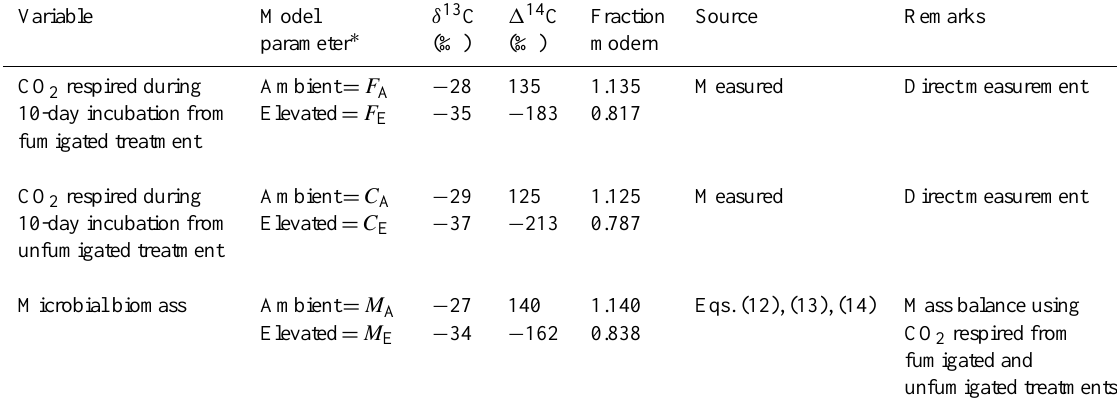
Table 5. Isotopic signatures of microbial biomass and biomass respiration measured for the sandstone topsoil (0–5cm) in April 1996. Variable Model δ 13 C 1 14 C Fraction Source parameter ∗ (‰) (‰) modern CO 2 respired during Ambient = F A − 28 135 1.135 Measured Direct measurement 10-day incubation from Elevated = F E 0.817